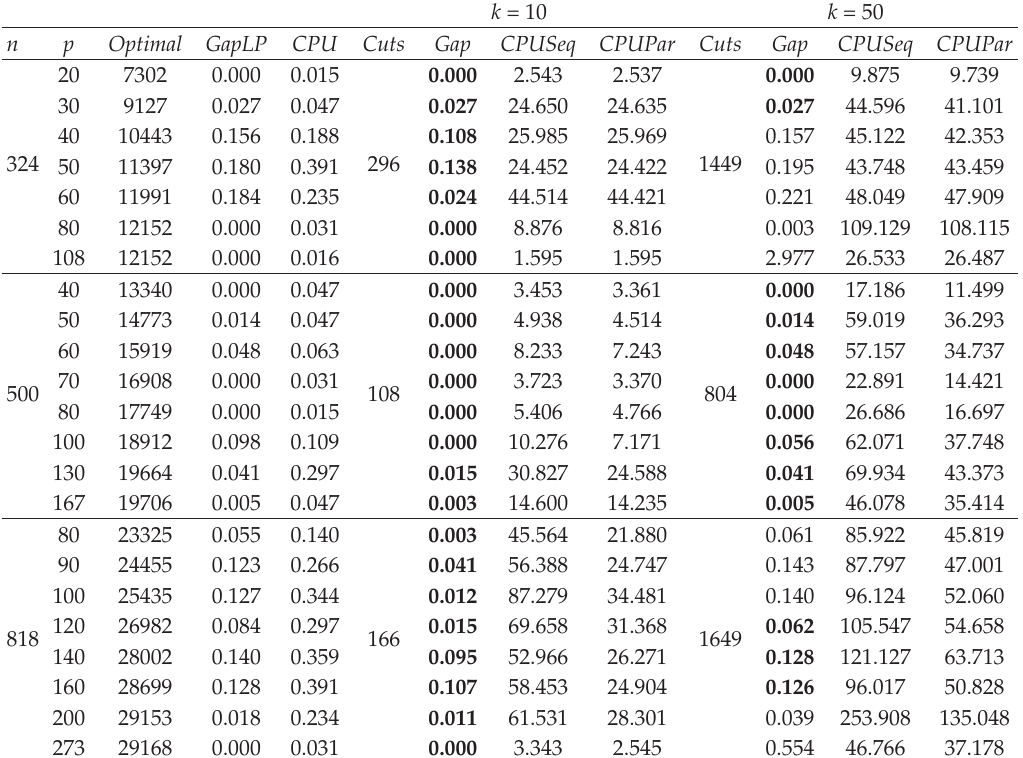
Table 1: Computation times for SJC instances, U (cid:6)